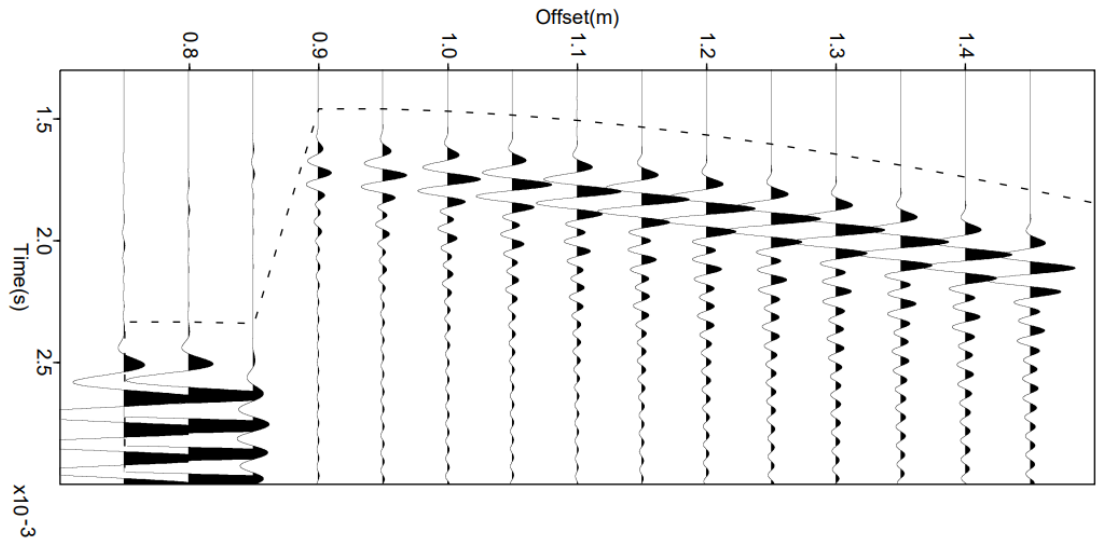
Figure 18. Seismograms obtained by full wavefield propagation using the finite differences method in the physical velocity model presented in Figure 16. The horizontal axis indicates the position of the sensors. The red arrow indicates the sensors located at the plumb of the source. The theoretical travel times calculated in the same model (M2) by the method proposed in Section 3.1 are plotted with a blue dashed line to assess the good agreement. We consider that the emitted signal was transformed by the loudspeaker (Figure 7b).